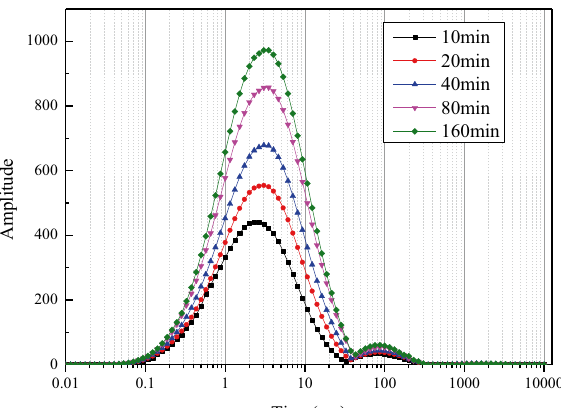
Figure 4. T 2 relaxation